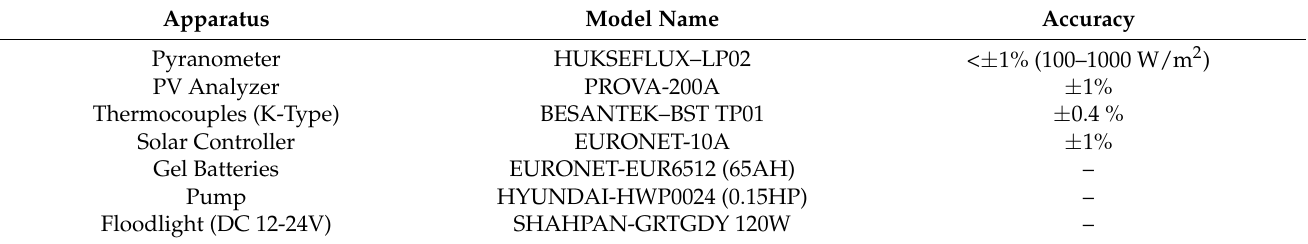
Table 3. The models’ name and accuracy of the apparatus used in the experimental setup.